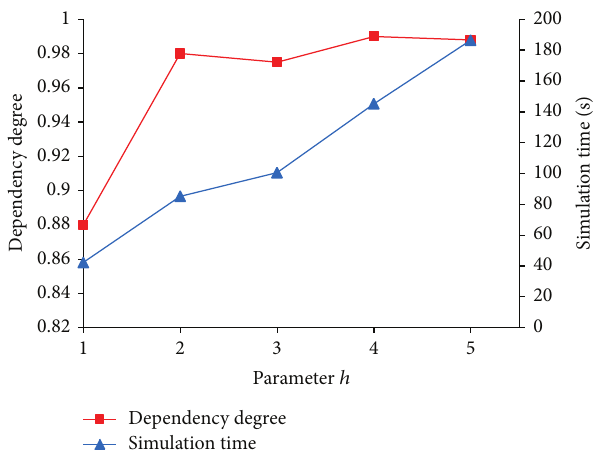
Figure 4: The change curves of dependency degree and simulation time.